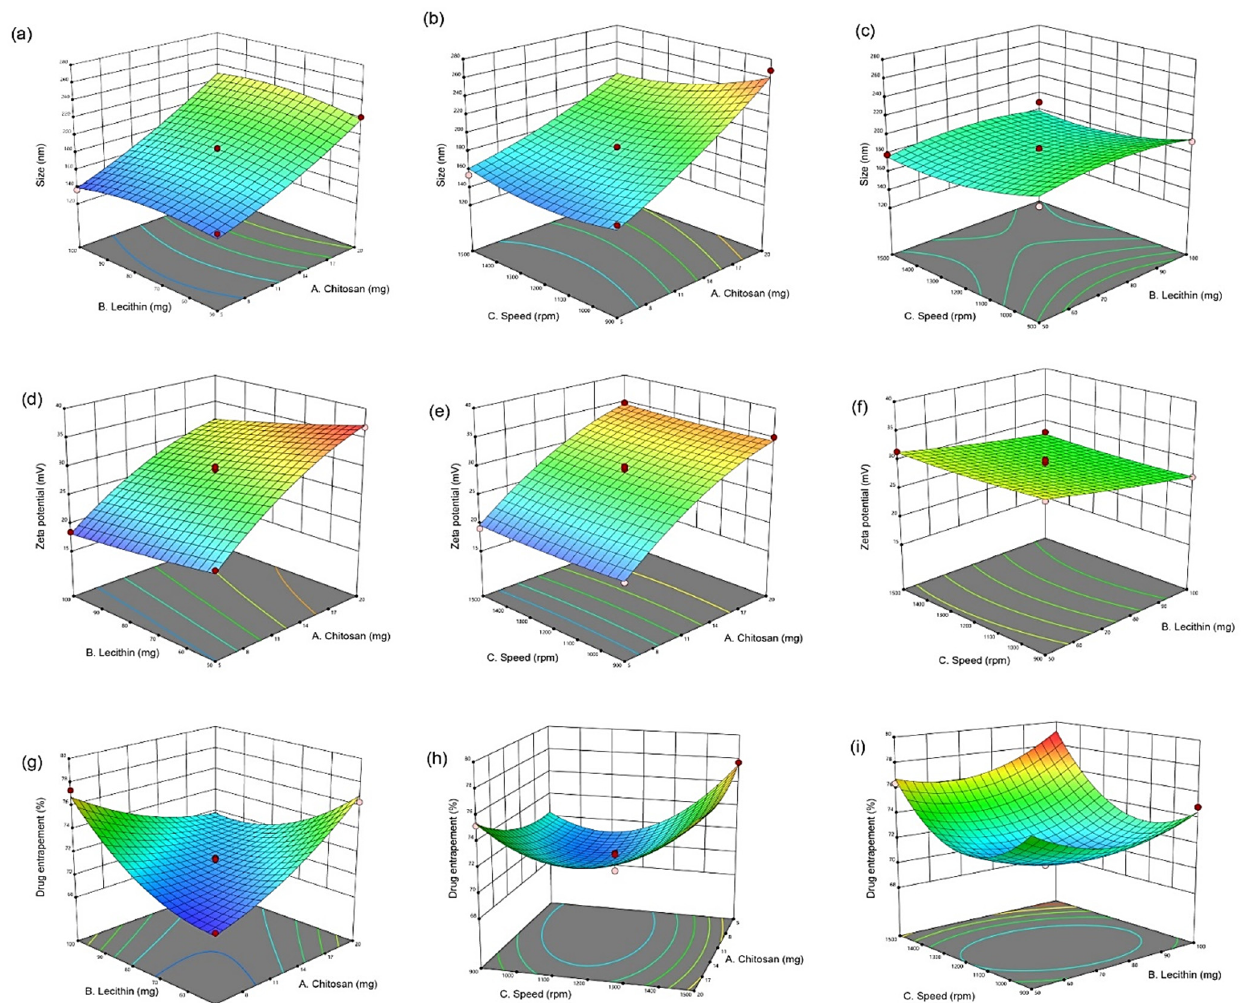
Figure 1. 3D-response surface plots for the graphical optimization of CUR/LCSNPs, illustrating the interaction effect of ( a ) lecithin and chitosan on mean particle size. ( b ) Speed and chitosan on mean particle size. ( c ) Speed and lecithin on mean particle size. ( d ) Lecithin and chitosan on ZP. ( e ) Speed and chitosan on ZP. ( f ) Speed and lecithin on ZP. ( g ) Lecithin and chitosan on EE(%). ( h ) Speed and chitosan on EE (%). ( i ) Speed and lecithin on EE (%).